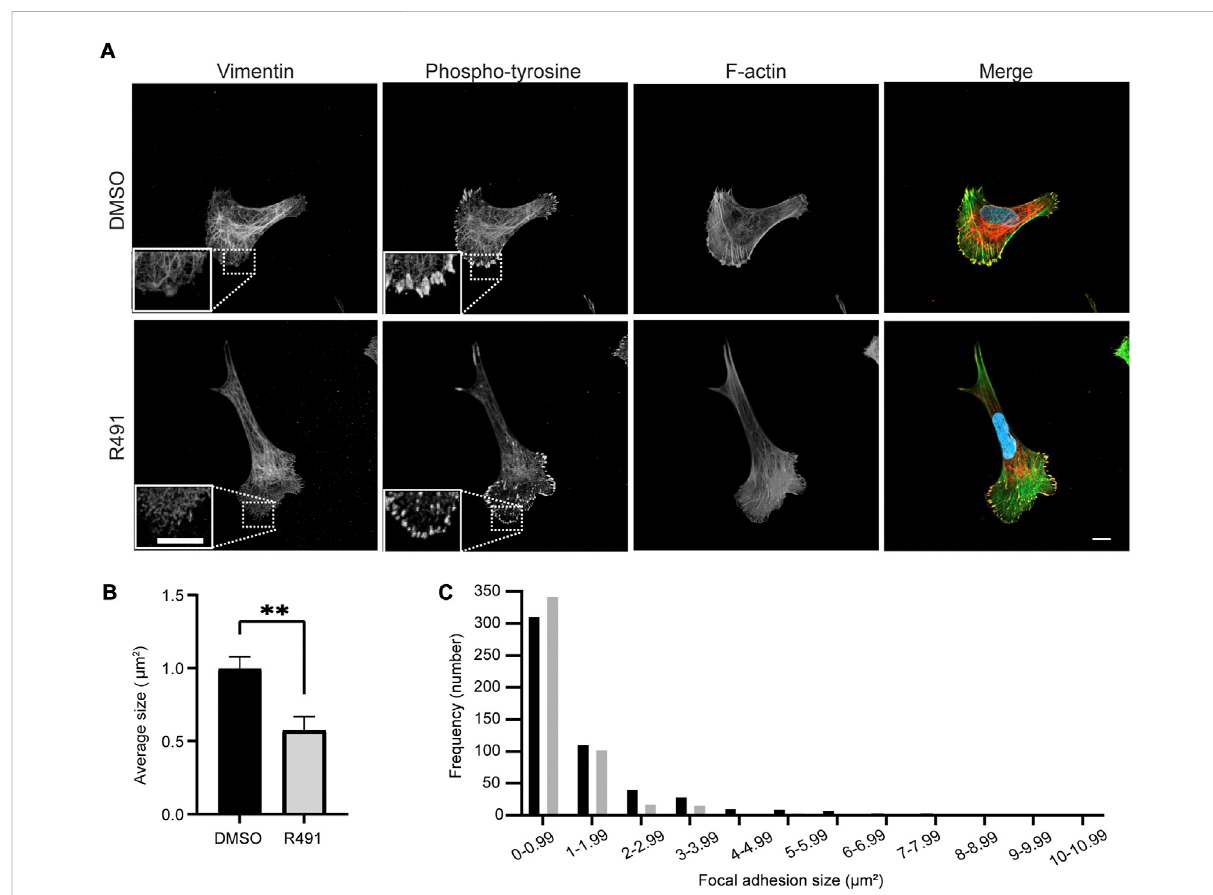
FIGURE 8 R491 increases the fraction and number of small focal adhesions. (A) Representative confocal microscopy images of BJ-Ras cells treated with 5 μ McontrolorR491,showingvimentin,phospho-tyrosine,F-actin,asindicated,andmergedimageswithvimentin(red),phospho-tyrosine(yellow), actin(green)andnuclei(blue).Insetimages:magni fi edviewsofboxedareasinthelargerimages.Scalebars:10 μ m.Thegraphsshow (B) theaverage size of cell-matrix adhesions/per cell, with n = 516 and 478 focal adhesions for control- and R491-treated cells, respectively, and (C) the frequency distribution of the binned sizes of focal adhesions of control- (black) or R491- (grey) treated cells. ** p ≤ 0.01. The difference in the frequency distribution was signi fi cant with p ≤